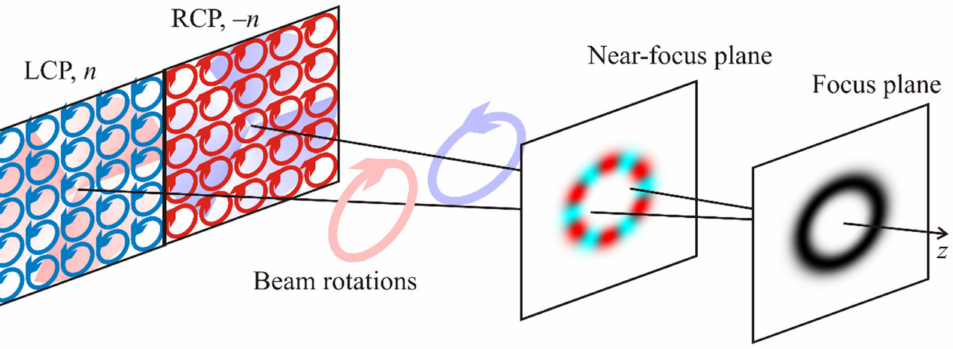
Figure 2. Generation of the optical spin Hall effect near the focus of two optical vortices: one with a positive topological charge n and with left circular polarization, and another with a negative topological charge – n and with right circular polarization. Due to the opposite angular momenta of the vortices, they rotate on propagation also in opposite directions and their interference generates near the focus a light field with alternating areas of positive and negative